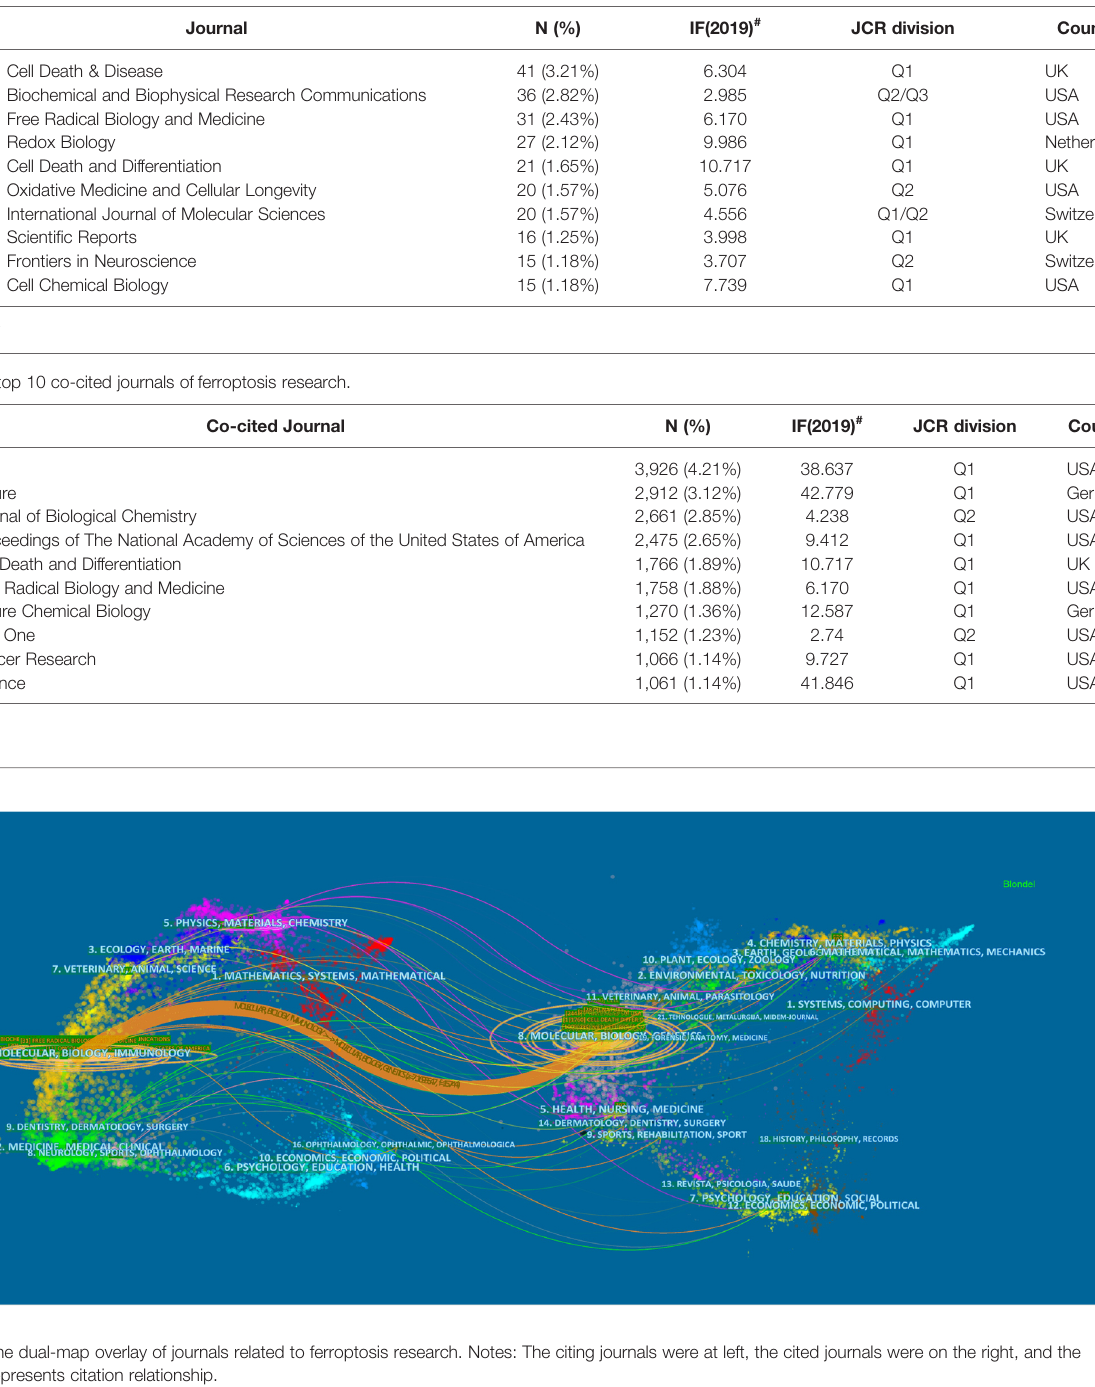
TABLE 1 | The top 10 journals of ferroptosis research.